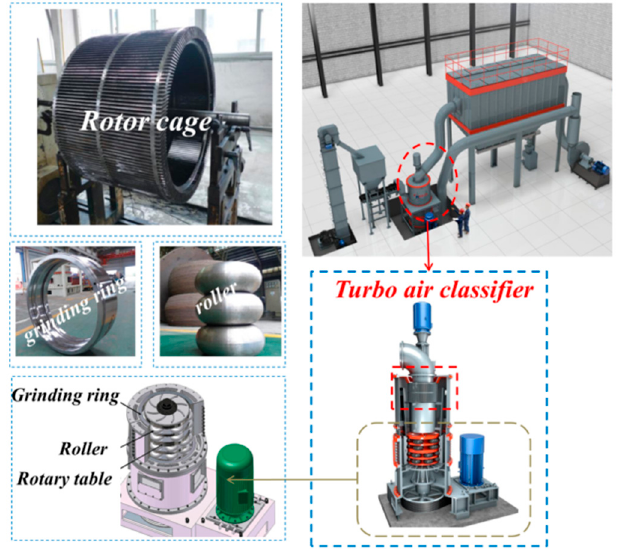
Figure 2. Scheme diagram of the pneumatic screening system.